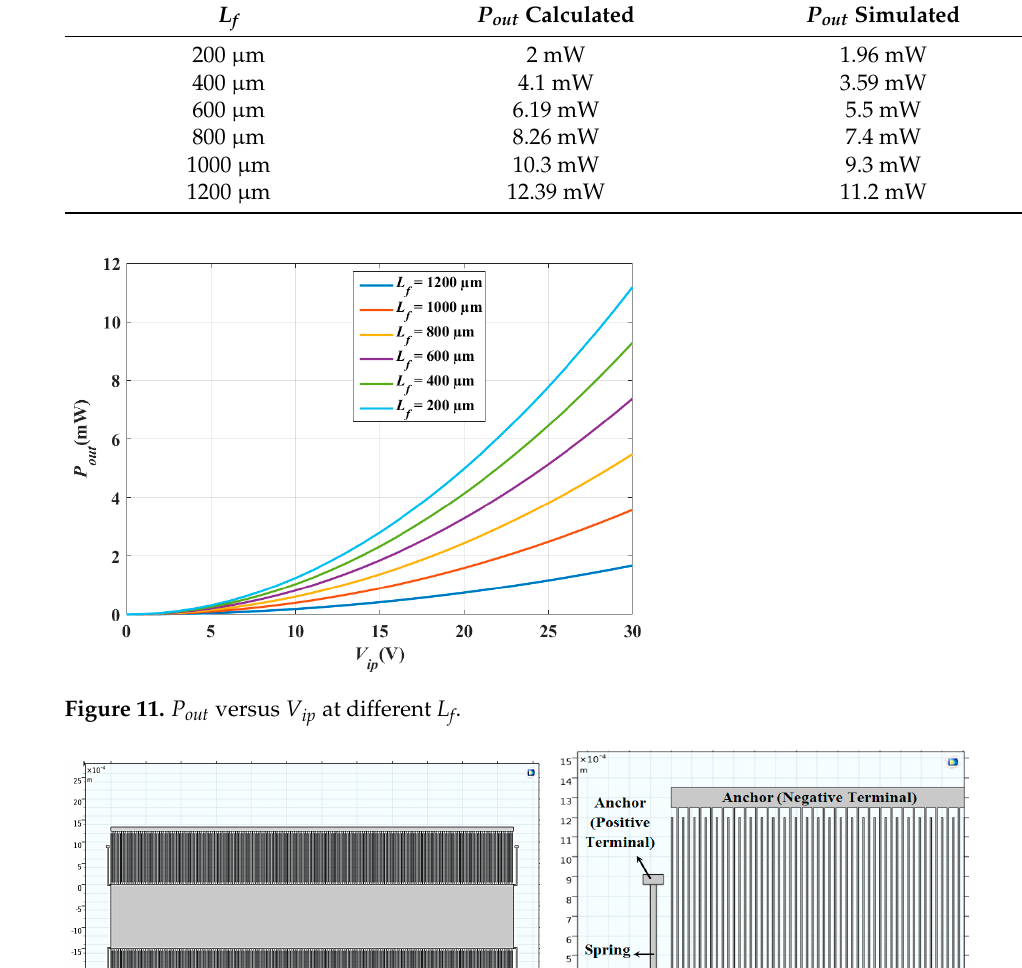
Table 3. P out at different L f.